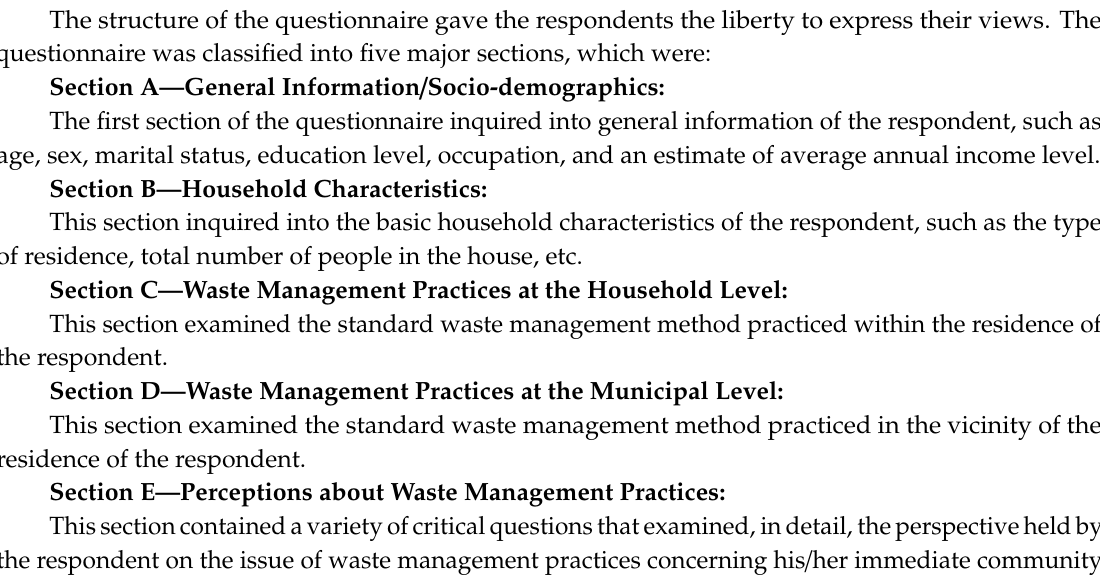
Figure 3. Cross-section of a vast open dump at Ado-Odo Local Government. 3. Results and Discussion The results are separated into three sections. The first section shows a summary of the general information and describes the socio-demographic features and household characteristics of the respondents of the survey. The second section shows a detailed breakdown of the solid waste management practices of the respondents at the household and municipal levels. The third section discusses results on the responses provided by the respondents on their perceptions of solid waste management. Analysis of the links between critical socio-demographic features of the respondents and their practices and attitudes of solid waste management is presented later in the third section. Three identified variables were vital in establishing relationships between respondents’ characteristics, methods, and perceptions in this study. They include age, education level, and annual income levels. The variables selected were based on the following two of the five limitations to effective waste management identified by [17], which are social limitations (for age and education level) and economic barrier (for annual income level), respectively. Other factors investigated include gender, occupation, frequency of collection, presence of an environmental task force/protection agency, and level of effectiveness of such task force/agency